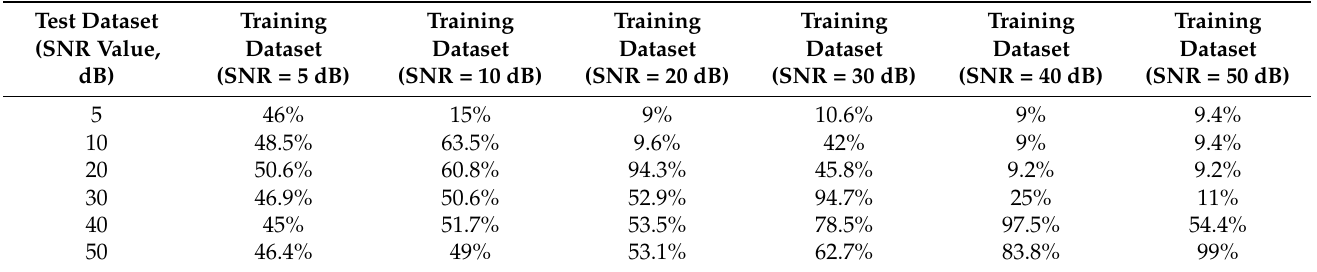
Table 3. The classification accuracy of the proposed model under different SNR values of the training and test